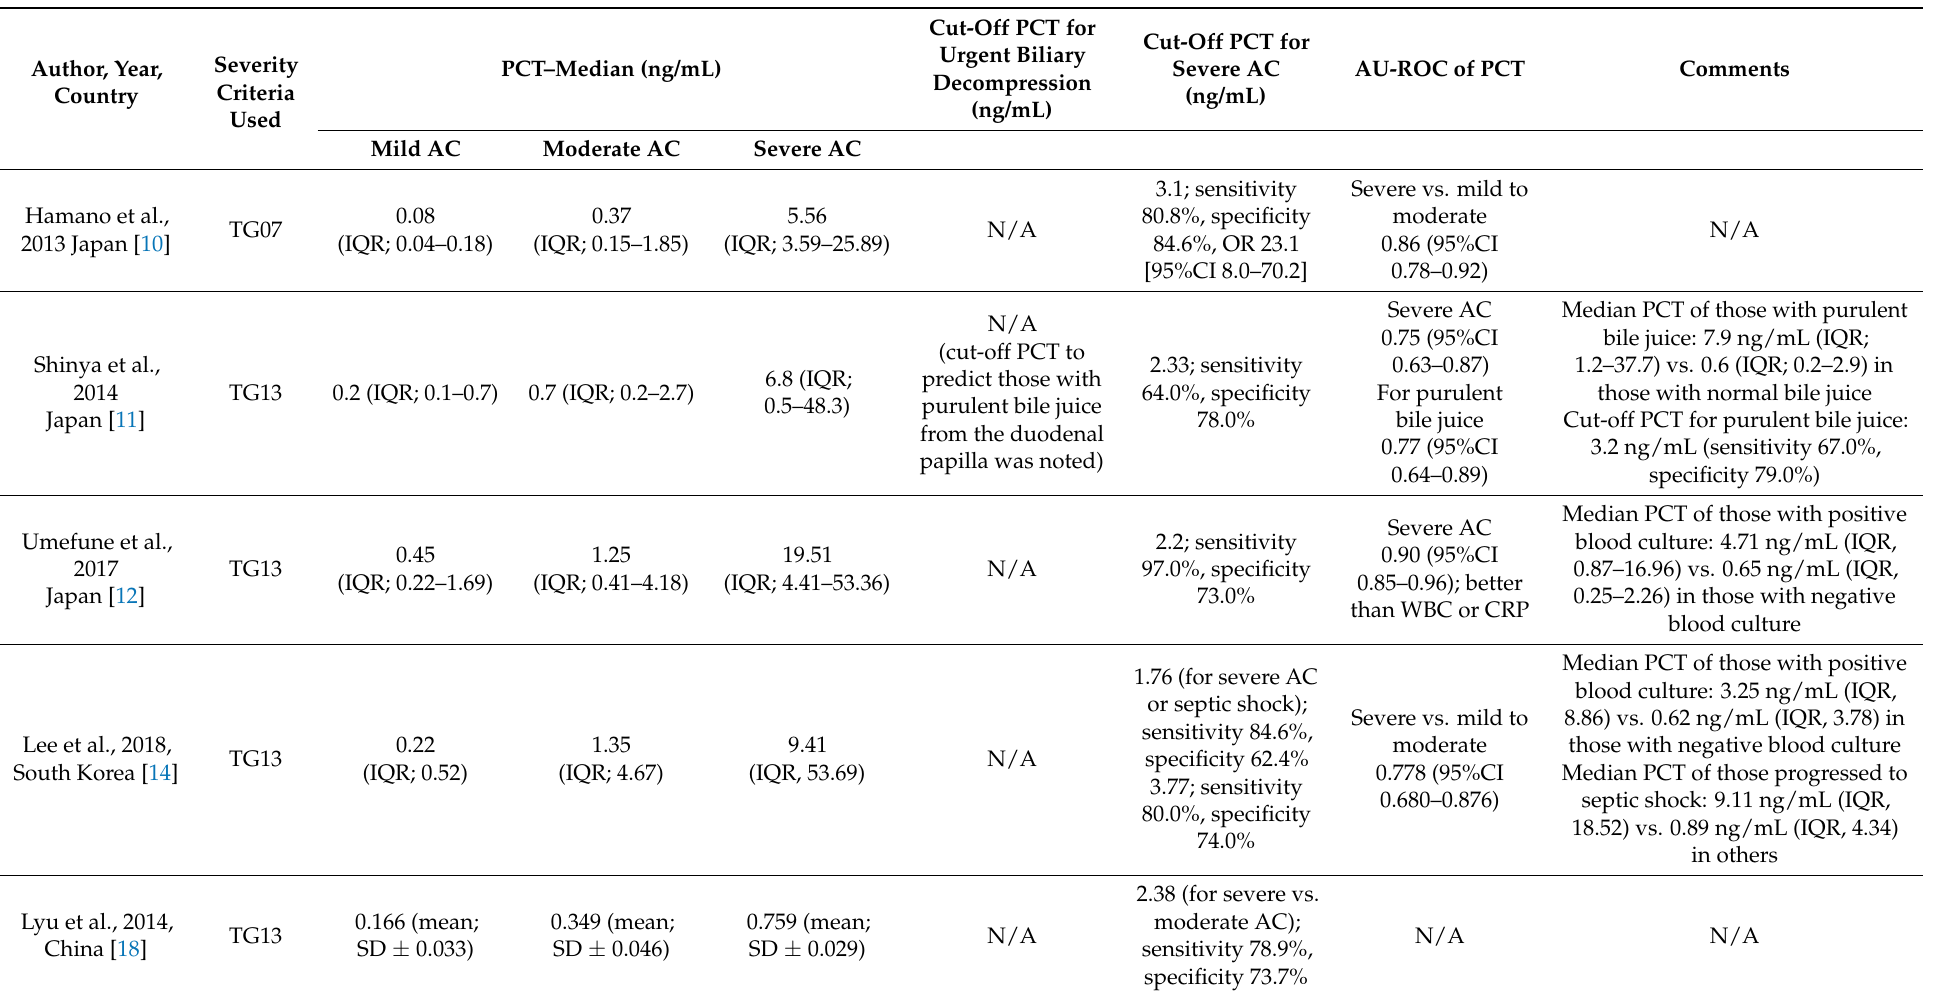
Table 2. Key findings related to serum procalcitonin levels in the included